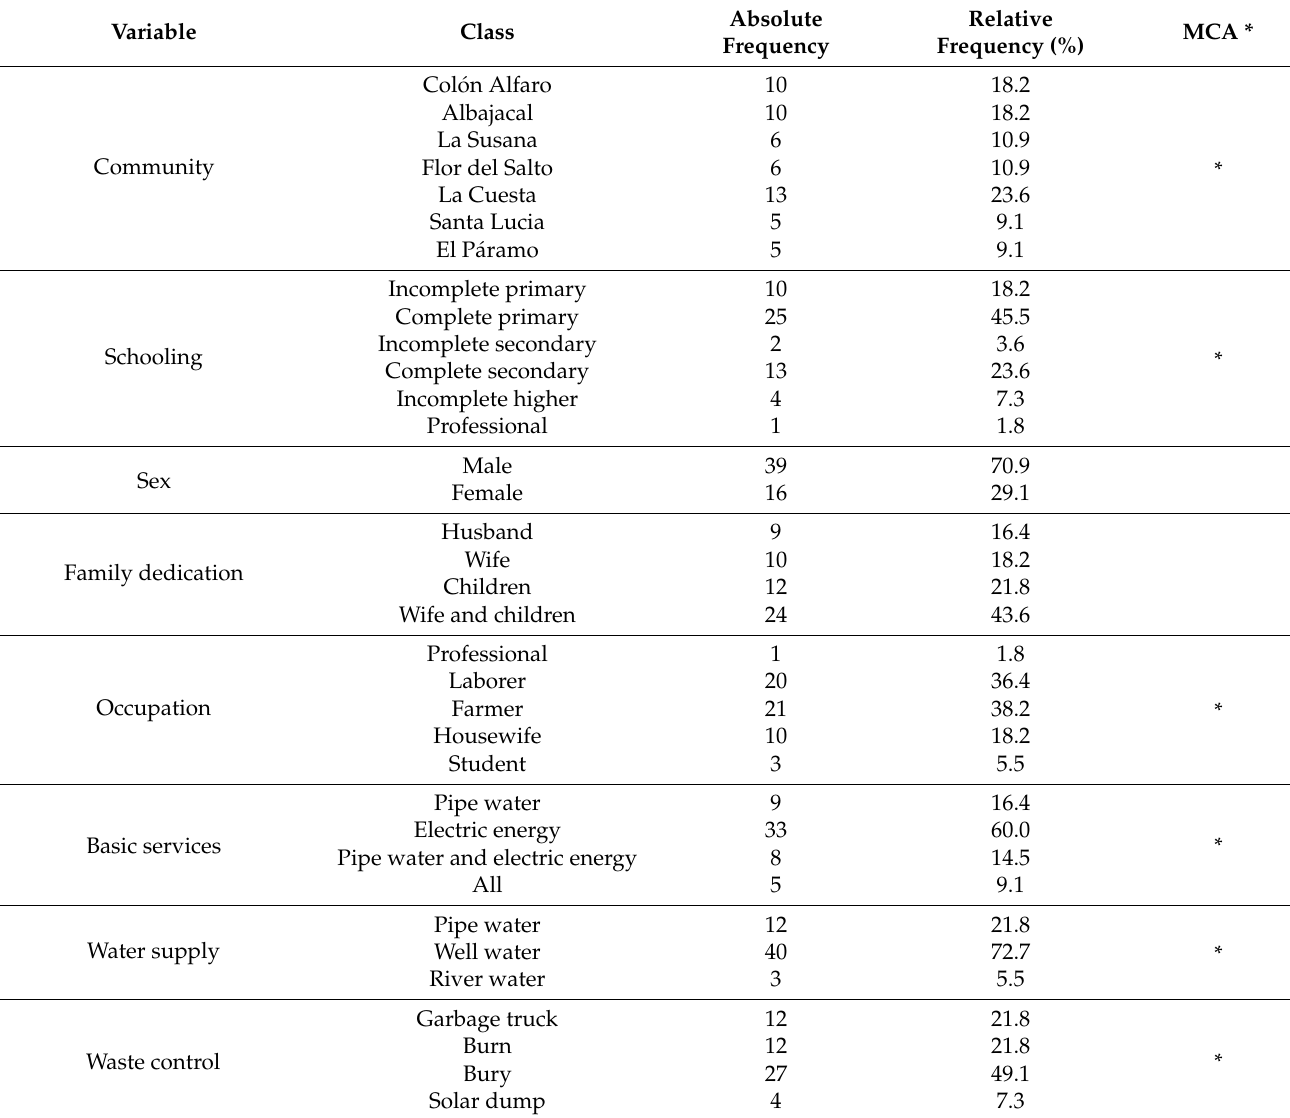
Table 1. Characteristics of socio-economic or structural confines of small pig producers of communities of El Anegado parish, Jipijapa (N = 55).